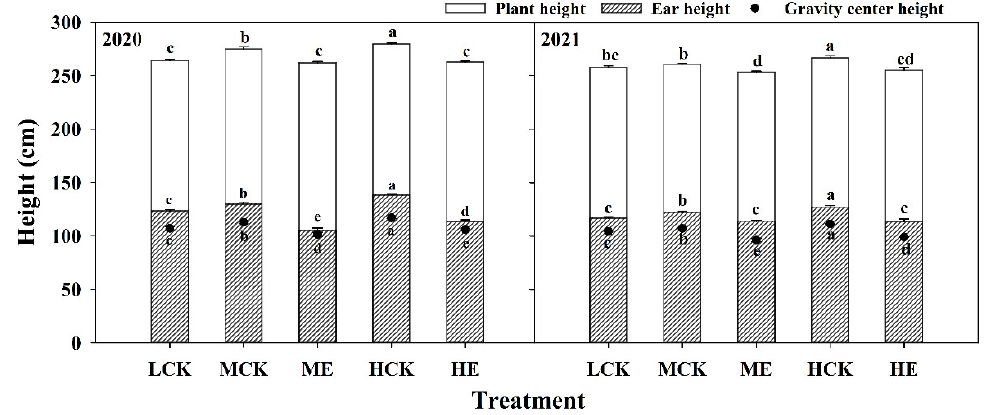
Figure 1. Effects of spraying ethephon on plant height, ear height and gravity center height of summer maize. LCK, MCK, ME, HCK and HE were the treatments of low density control, medium density control, medium density sprayed with ethephon, high density control and high density sprayed with ethephon, respectively. Different lowercase letters in the figure indicated significant difference at 5% level.